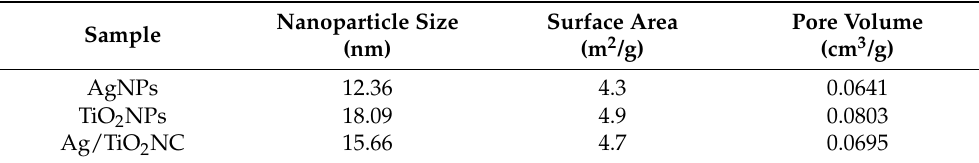
Table 3. Average surface area and pore volume of pure AgNPs, pure TiO 2 NPs and Ag/ TiO 2